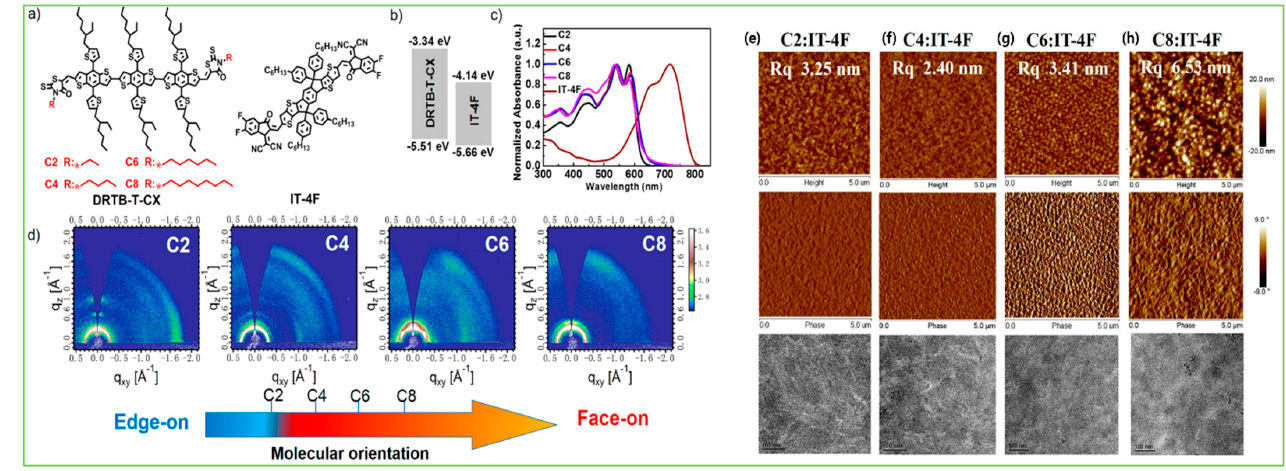
Figure 13. ( a ) Molecular structure of DRTB − T − CX and IT − 4F. ( b ) Energy level diagram of the donor and acceptor materials. ( c ) Normalized thin-film UV − vis absorption spectra of DRTB − T-CX and IT − 4F. ( d ) Two-dimensional GIWAXS patterns of pristine C2, C4, C6, and C8. ( e – h ) AFM height and phase images and brightfield (BF)TEM images of films spin coated from the DRTBTCX:IT4F blends with SVA treatments. Adapted with permission from [104]. Copyright 2018, American Chemical Society.